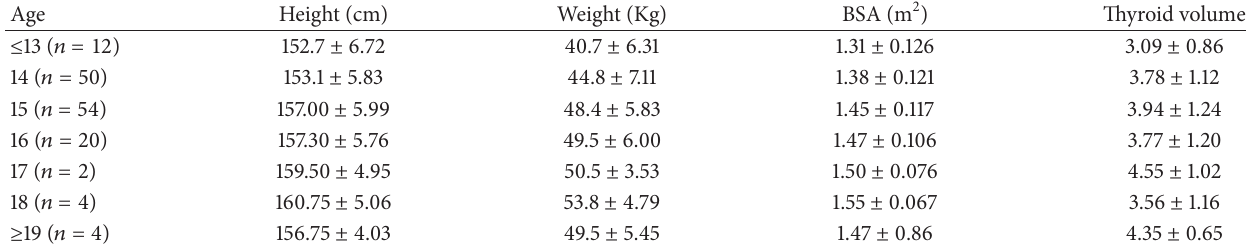
Table 2: Height, weight, and thyroid volume according to